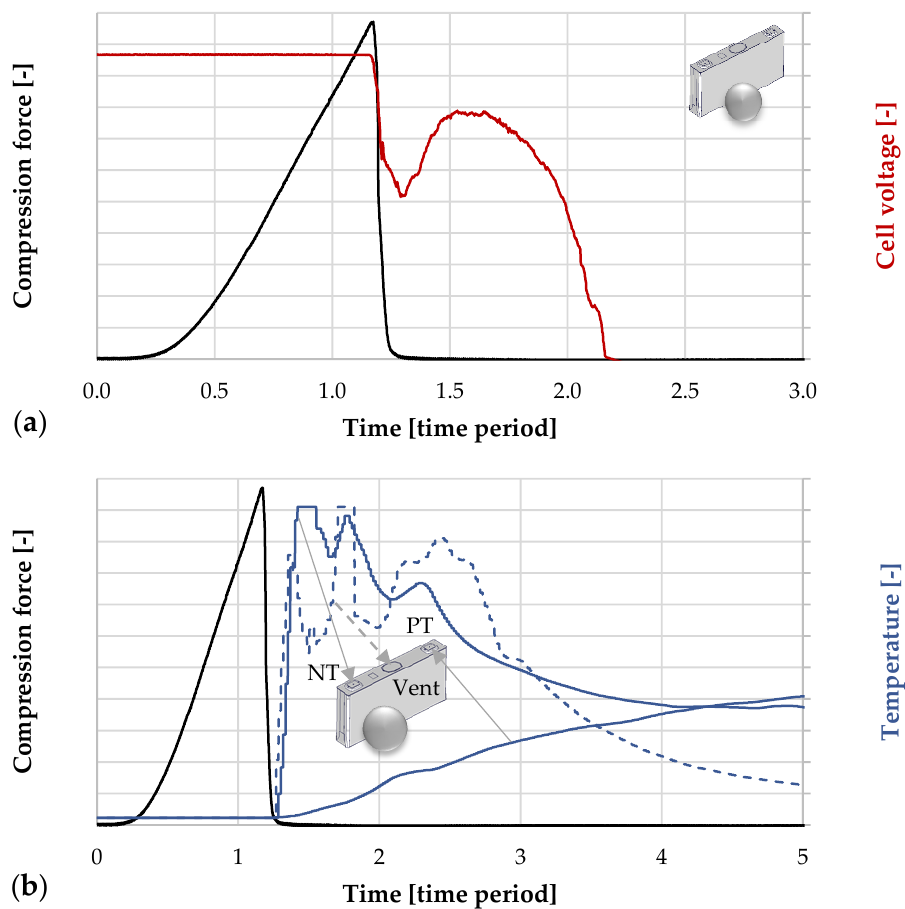
Figure 3. Test data of test QT01: ( a ) compression force and cell voltage over time; ( b ) compression force and temperature over time (NT: negative terminal, PT: positive terminal).